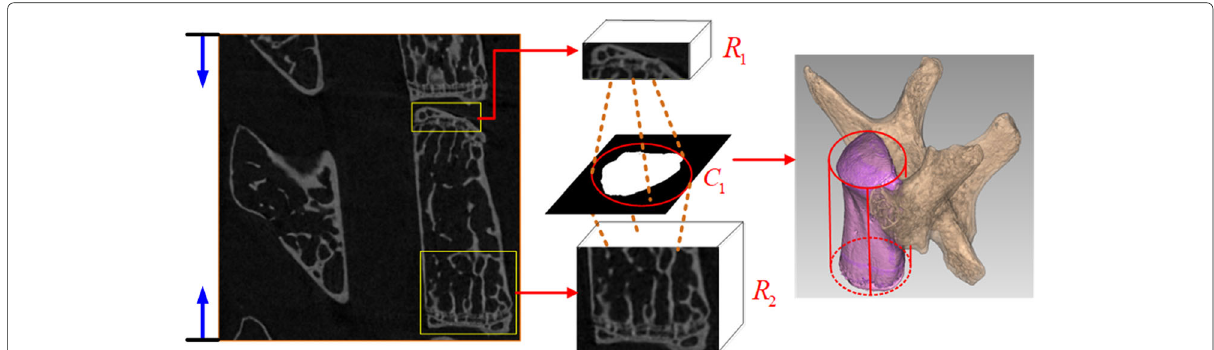
guidance for the segmentation. As for endplate segmenta- tion, there are two kinds of shape priori according to our observation. The first one is that there appears a concave gap between the endplate and the adjacent body, which can be observed from its 3D geometry. We use the yellow dotted line in Fig. 6a to show this 3D shape priori. The sec- ond one is the shape similarity between the internal and external edge of endplate, which can be approximated by the green and red dotted line in Fig. 6b